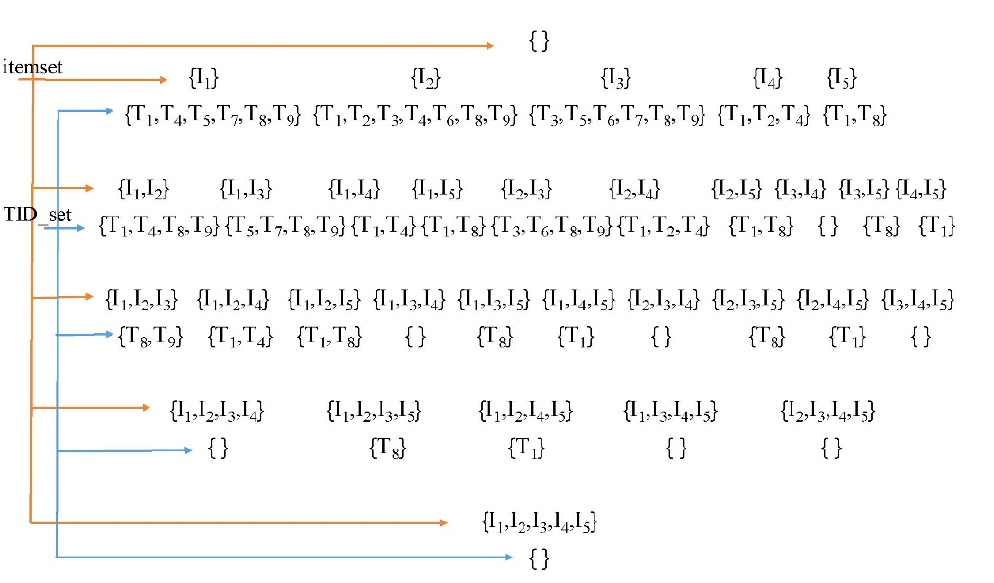
Table 1. A transaction database.